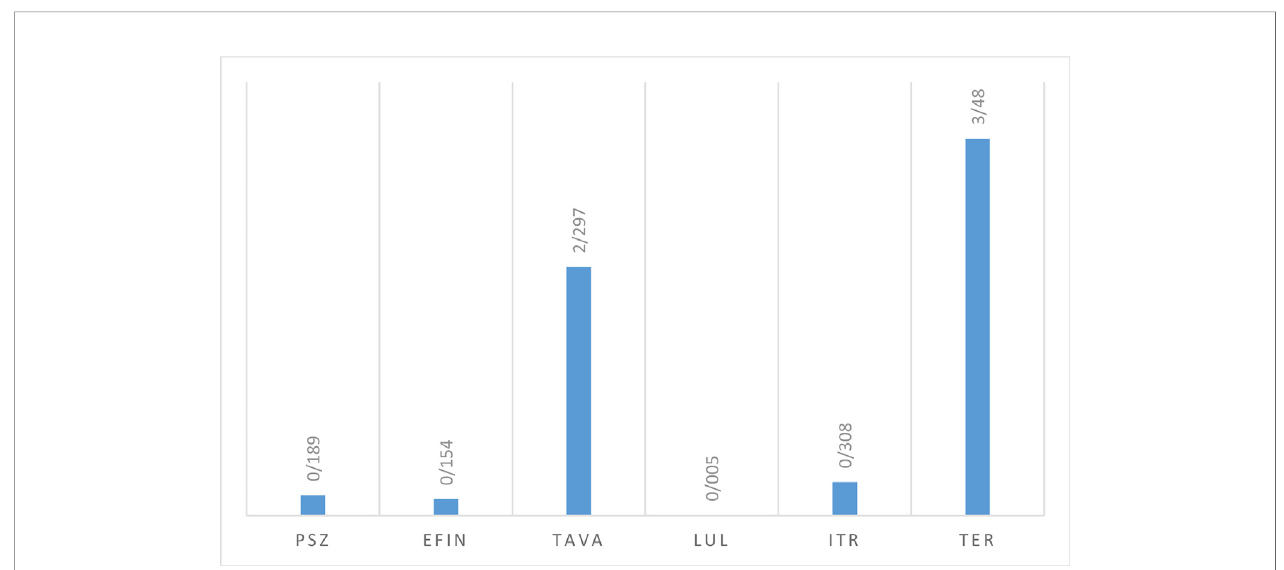
FIGURE 4 | The geometric mean obtained by testing the susceptibility of saprophytic isolates to each antifungal agent.